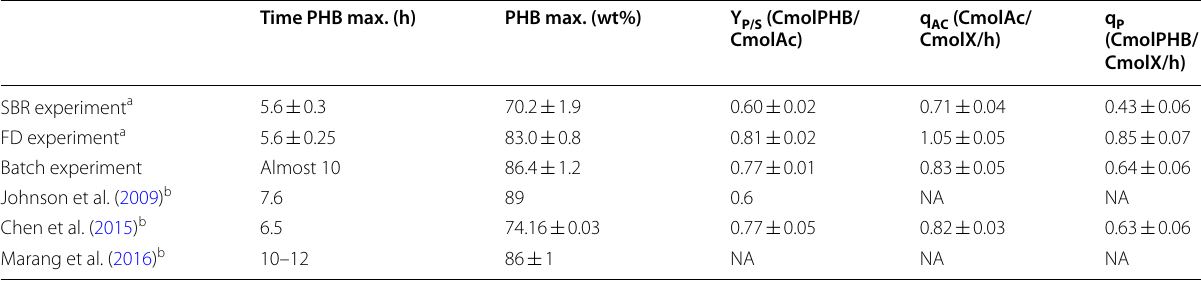
a To keep the same feast length, the amount of Ac was 124.5 and 182 Cmmol/L in SBR and FD experiment, respectively b Date from the accumulation experiments of the three